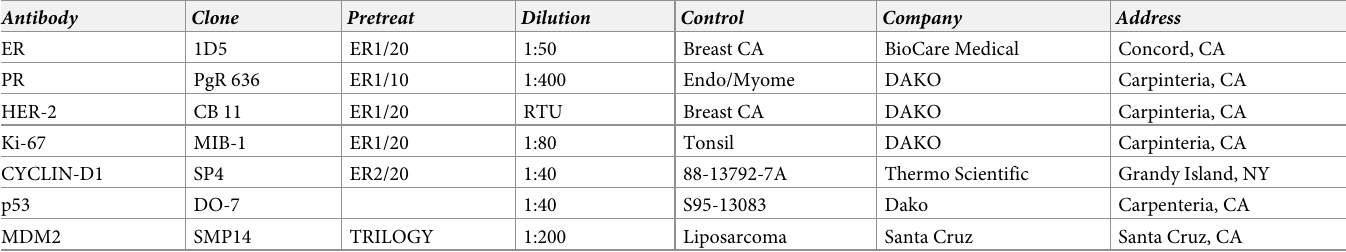
Table 1. Various antibodies used in the